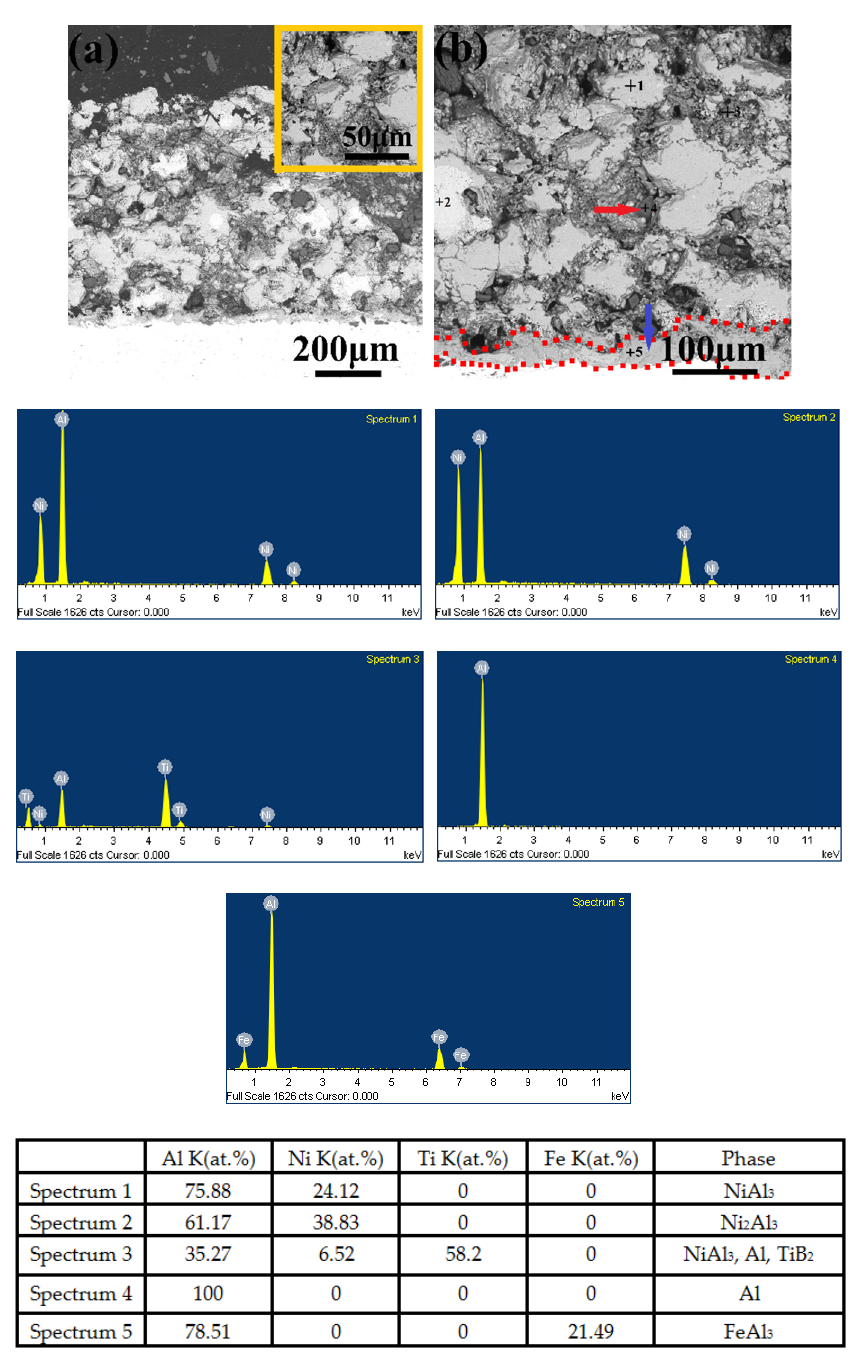
Figure 13. Cross-sectional morphologies and compositions of Ni/Al-TiB 2 coatings as-sprayed at 450 °C and after annealing at 650 °C for 20 h: ( a ) 200×, and ( b ) 500×.